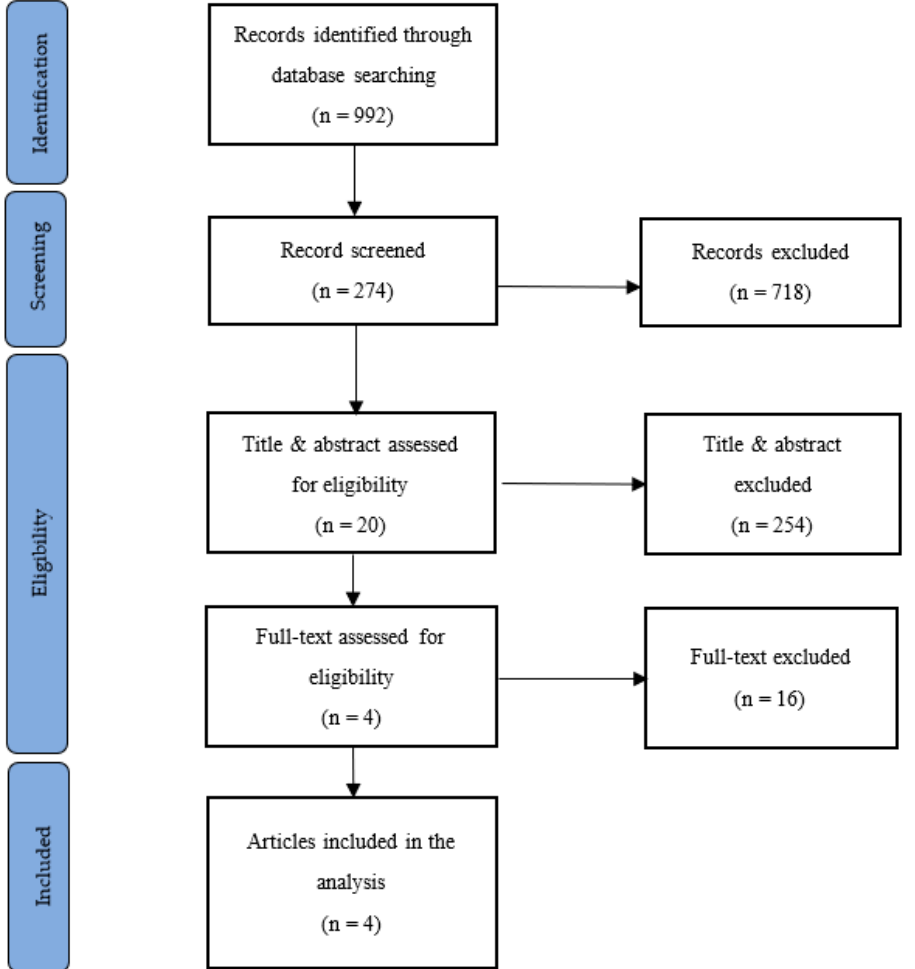
Figure 1. PRISMA flowchart of ISOP model.